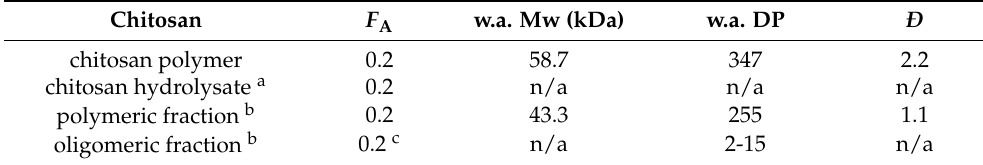
Table 1. Chitosan analysis